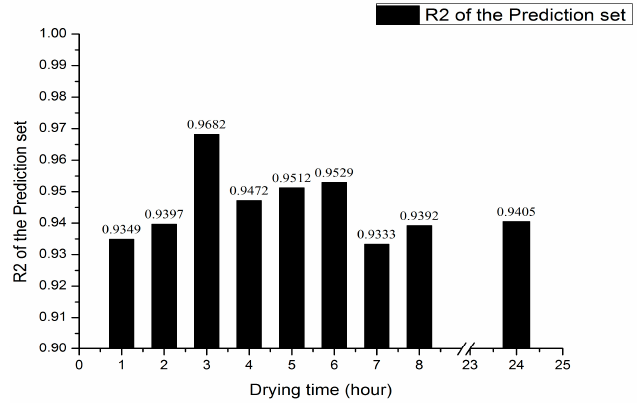
Figure 5. Histogram of uninformative variable elimination (UVE) model performance under different drying time.